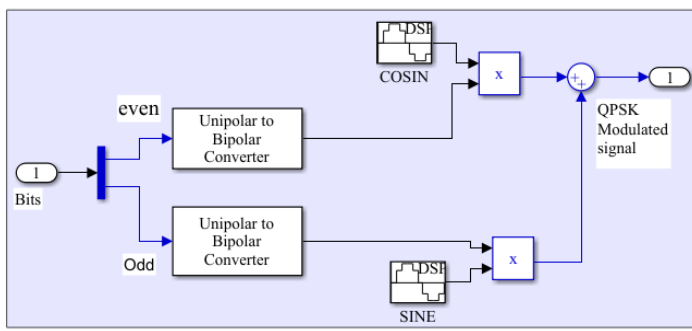
Figure 6. QPSK modulator circuit implemented in SIMULINK.